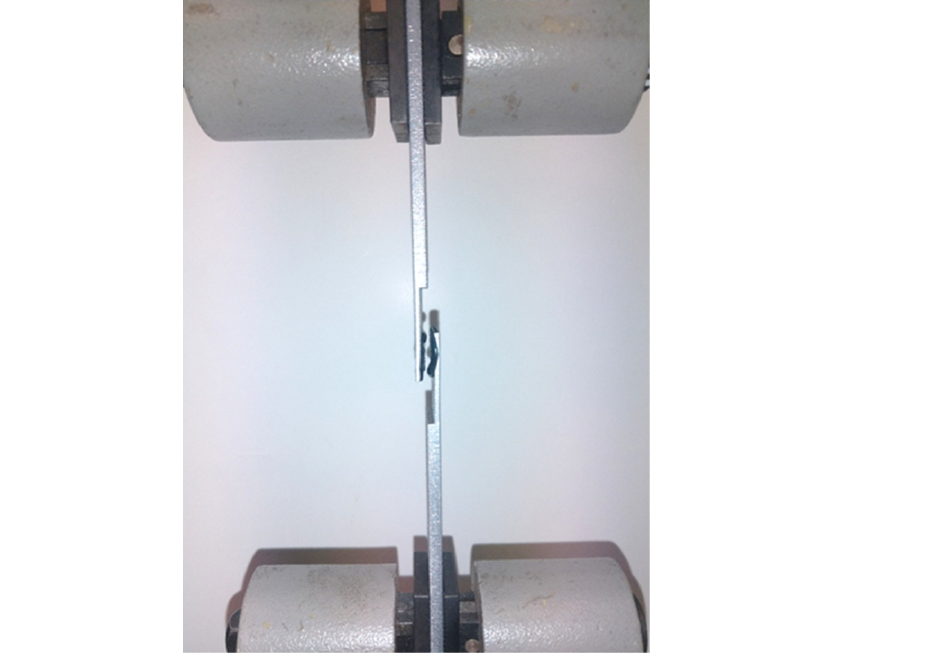
Figure 6. View of the sample after the shear test.